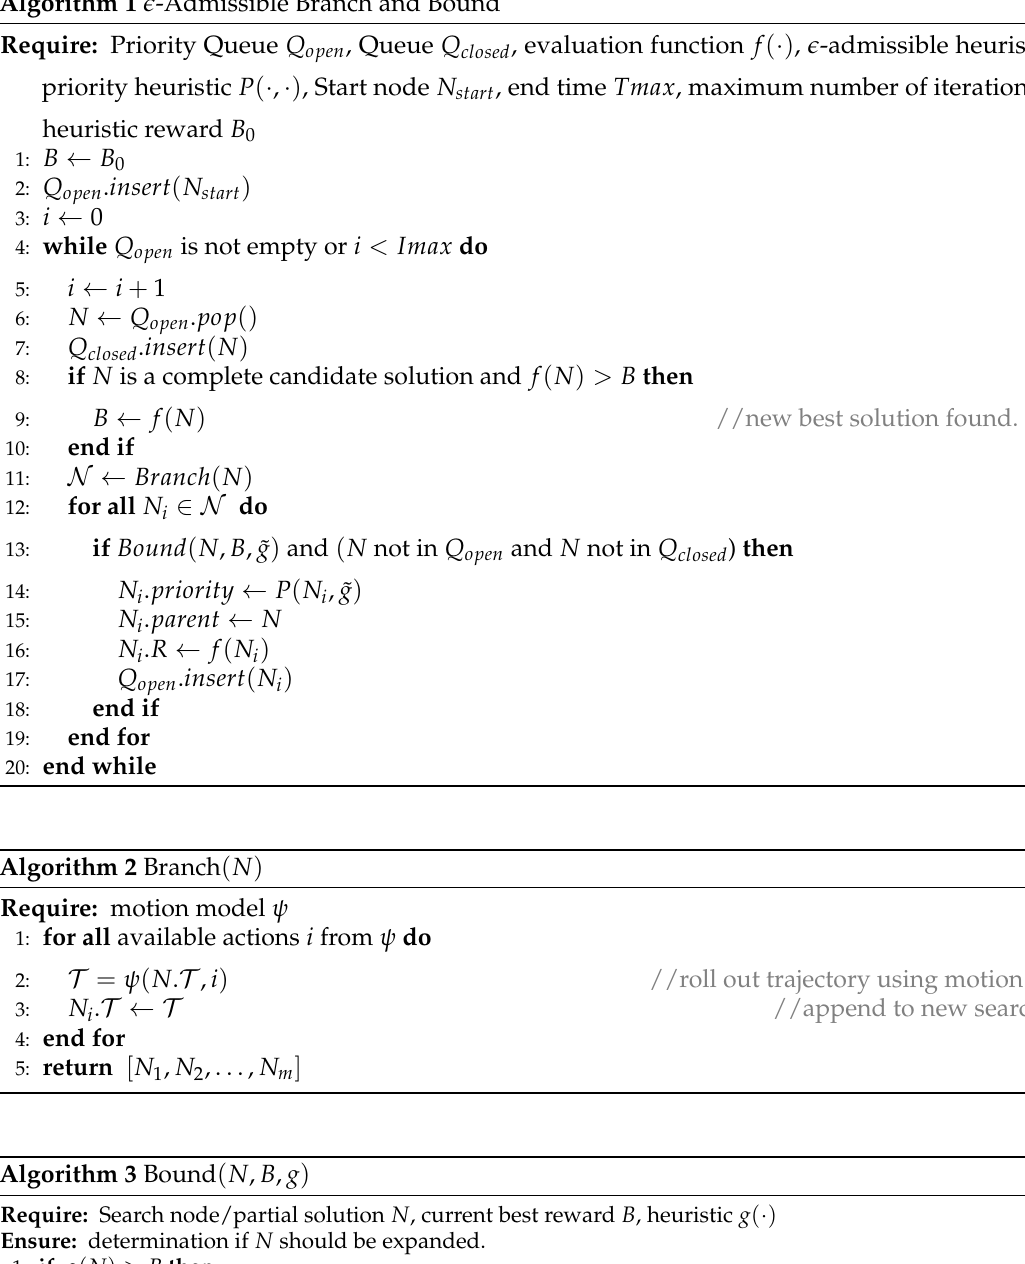
Algorithm 1 (cid:101) -Admissible Branch and Bound